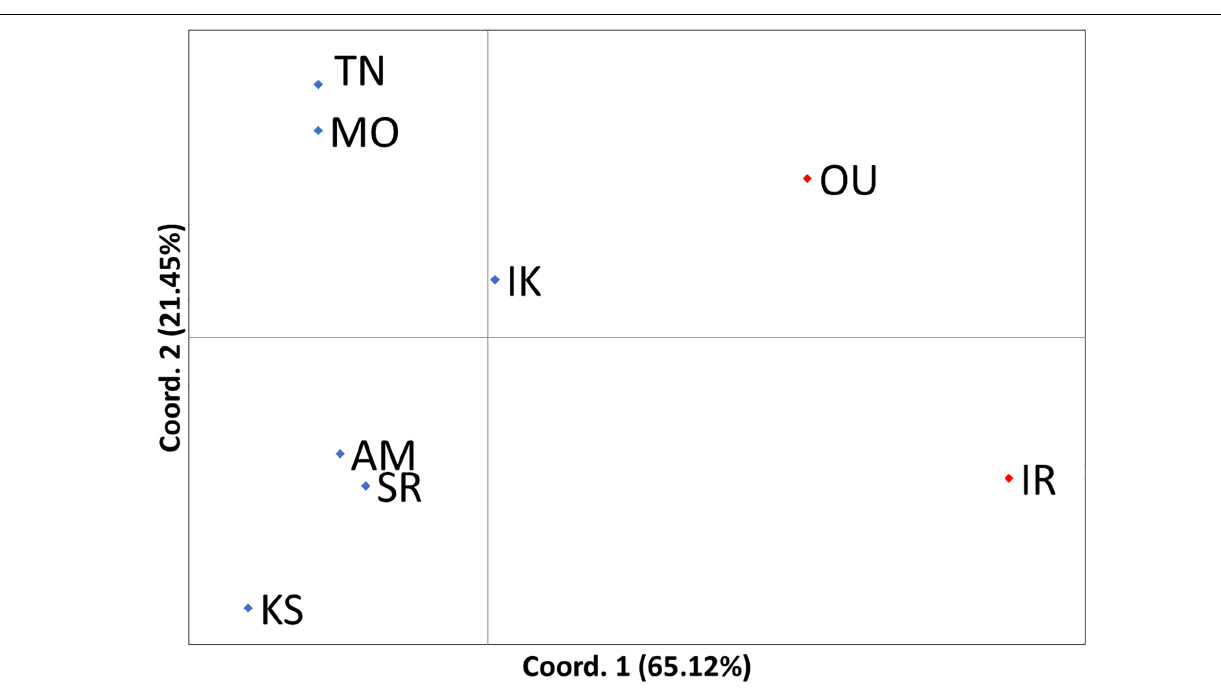
FIGURE 5 | Population-based principal coordinate analysis. Coordinate 1 explained 65.12% of the variation in the data and coordinate 2 explained 21.45% of the variation. Blue rhomboids indicate temperate populations and red rhomboids indicate subtropical populations. The name of the sites corresponding to each abbreviation is found in Table 1